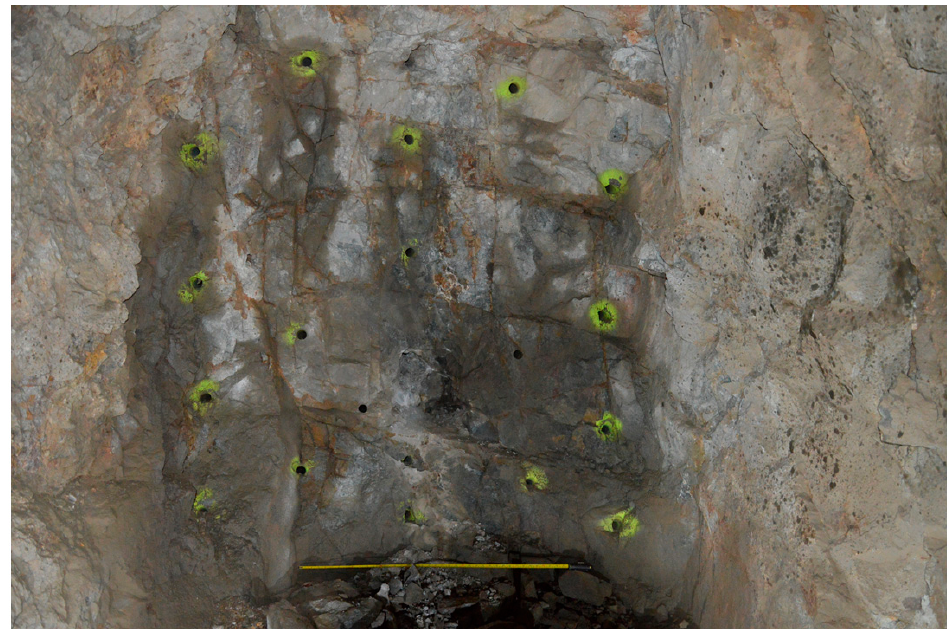
Figure A3. Cavity after detonation of hole with sequence number 2.